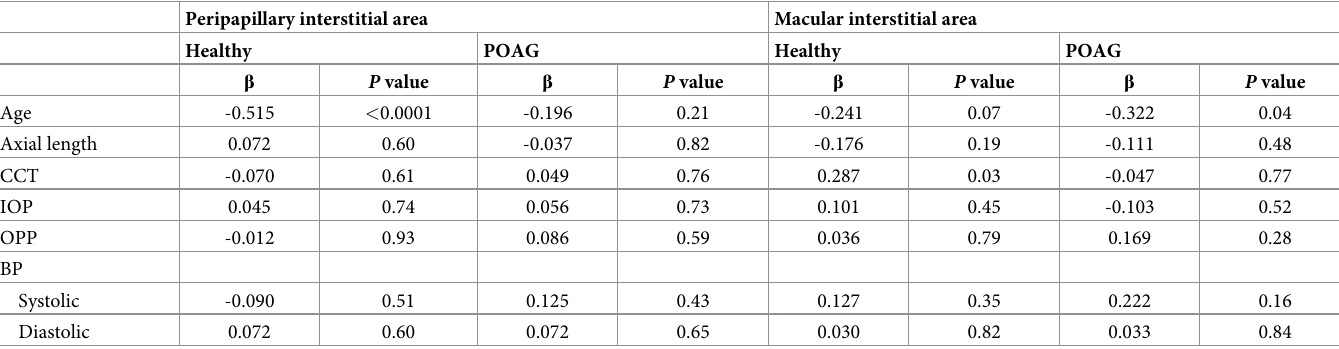
Table 6. Univariate regression analysis of choroidal interstitial area with associated